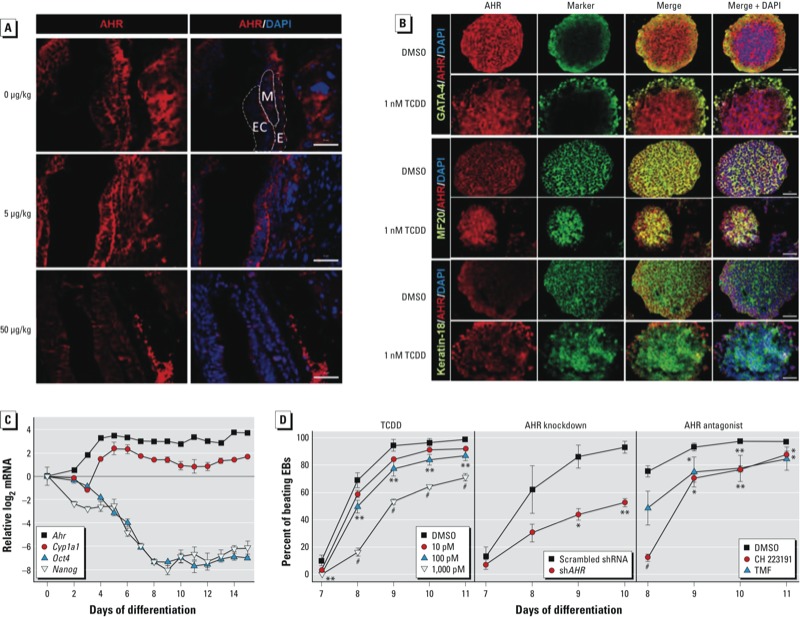
Detection of AHR in embryos (A), EBs (B,C), and cardio­myocytes (D). (A) Embryos were exposed to corn oil vehicle or TCDD (5 or 50 μg/kg) on GD5.5 and examined by immuno­fluorescence on GD7.5. Abbreviations: E, endoderm; Ec, ectoderm; M, mesoderm. (B) Immunofluorescence detection of lineage markers [AHR, GATA4, MF20 (cardiomyocytes), and keratin-18] in 3‑day-old EBs treated with TCDD (1 nM) or DMSO vehicle (≤ 0.05% in media). Columns 1 and 2 show immuno­fluorescence with AHR or the individual marker antibody, respectively; column 3 shows the merge of columns 1 and 2; and column 4 shows the merge of column 3 with the DAPI nuclear stain. Magnification for A and B, 20×; bars = 20 μm. (C) Expression patterns of Ahr, Cyp1a1, Oct4/ (Pou5f1), and Nanog in differentiating EBs presented as the ratio of log2 qPCR mRNA level for each day of differentiation (normalized to Gapdh) to the corresponding level in ES cells (differentiation day 0). (D) Effect of TCDD treatment, Ahr knockdown, and AHR antagonists TMF and CH 223191 (10 μM each) on cardio­myocyte contractility in 3‑day-old EBs that were allowed to differentiate; EBs were examined daily under the microscope for the presence of a rhythmic beating phenotype. In C and D, data represent the mean ± SD of three independent experiments.
*p < 0.05, **p < 0.01, and #p < 0.001, compared with vehicle control by Bonferroni-corrected ANOVA.